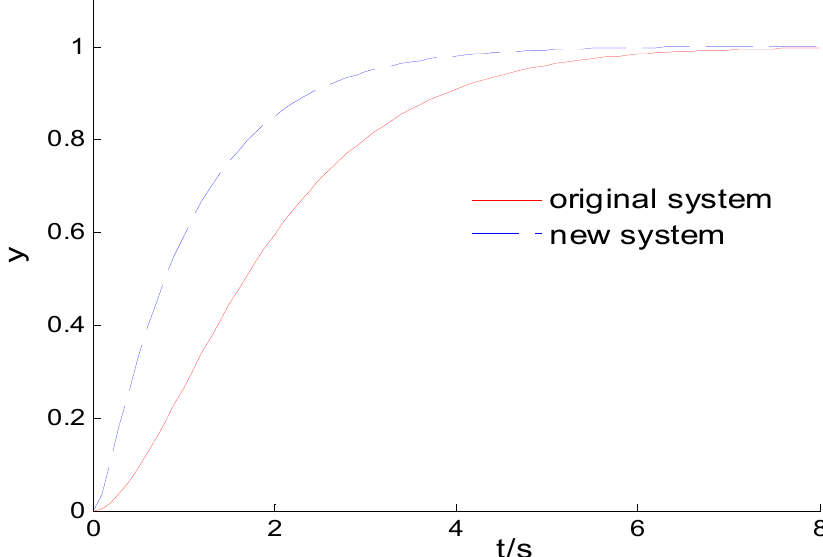
Figure 2. Step Response of Systems with Different Time Constants.